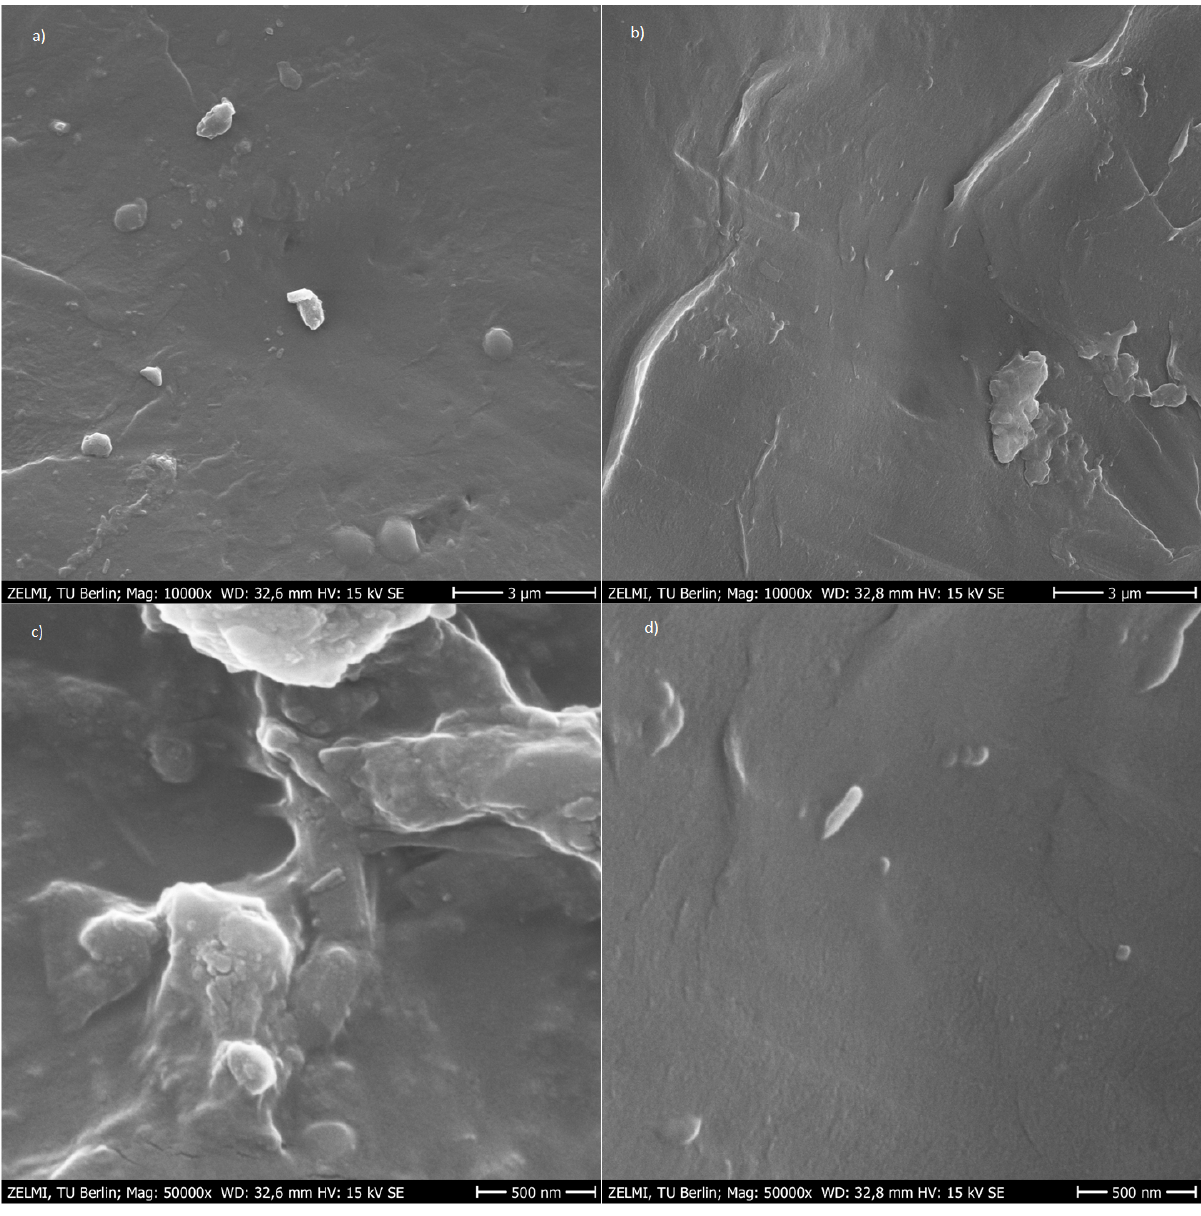
Figure A1. ( a ) ultrafiltration flat sheet membrane 100 kDa 10,000 × magnification, ( b ) ultrafiltration flat sheet membrane 30 kDa 10,000 × magnification, ( c ) ultrafiltration flat sheet membrane 100